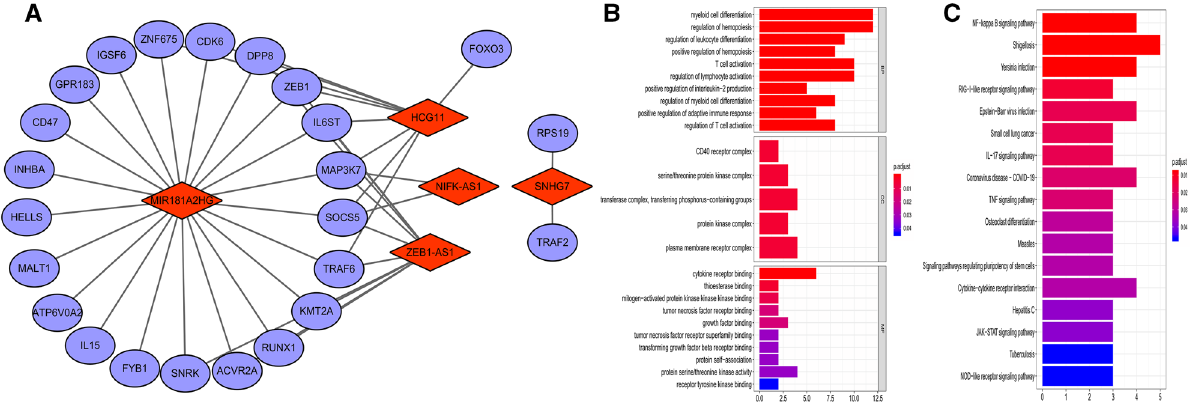
Figure 5. The co-expression network and functional enrichment analysis of the immune-related lncRNA signature. ( A ) The co-expression network between the immune-related genes and prognostic lncRNAs in CRC.